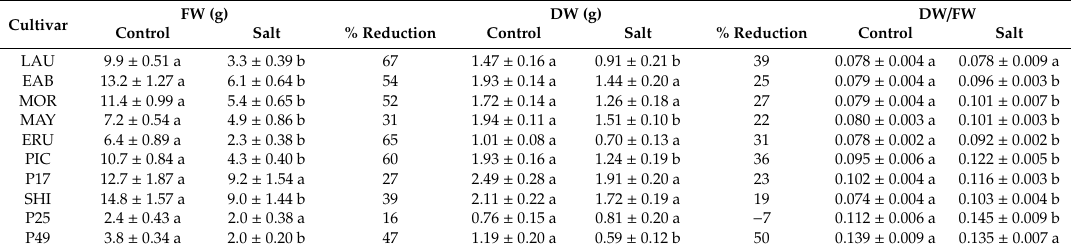
Table 1. E ff ect of salinity on fresh and dry weight of lettuce plants. FW (g) DW (g) DW / FW Cultivar